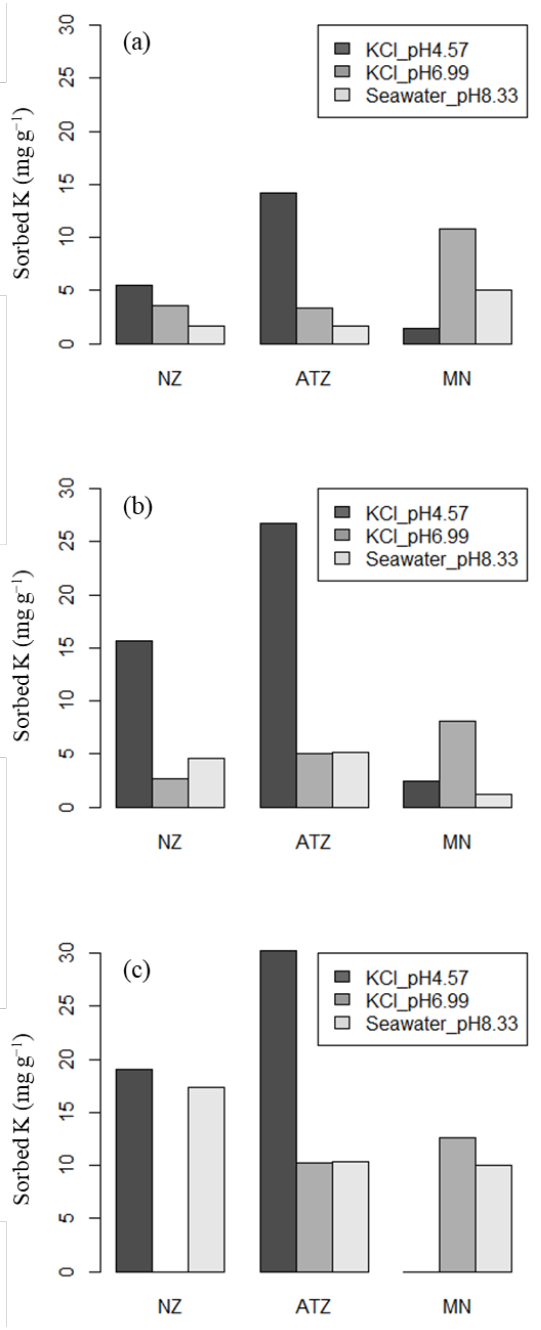
Figure 6. Sorption of potassium (K) on different adsorbents (i.e., natural zeolite (NZ), ammo- nium acetate-treated zeolite (ATZ), and manganese nodule (MN)) at average K concentration